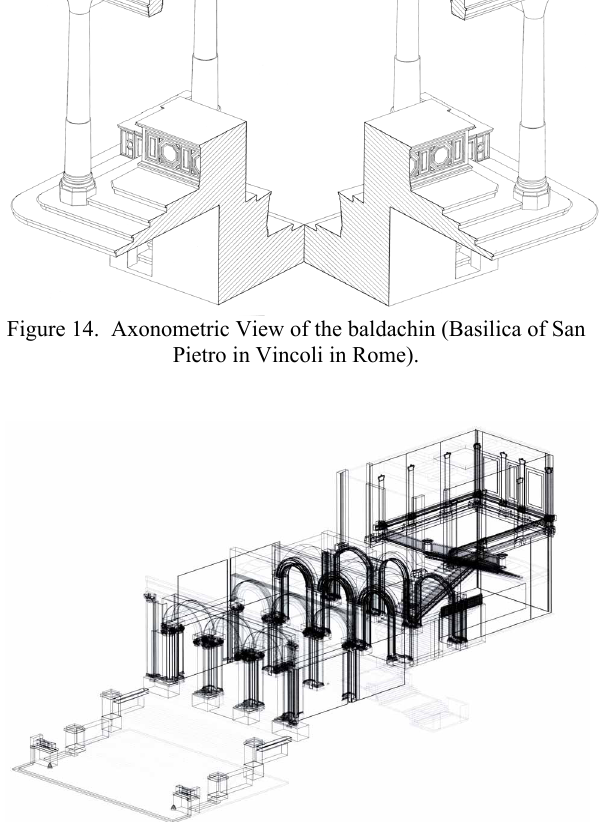
Figure 15. View of the model in wireframe (Basilica of San Pietro in Vincoli in